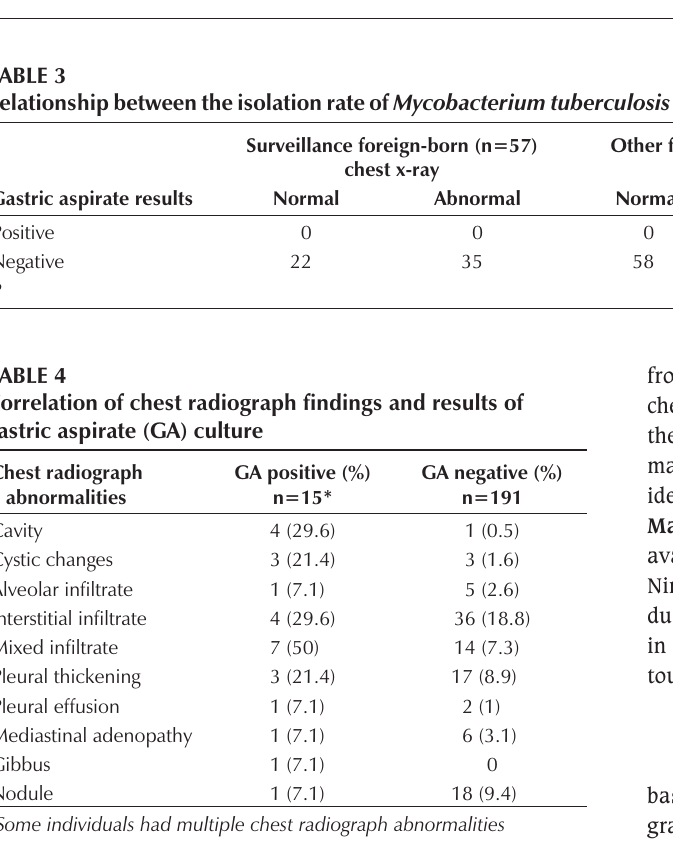
Relationship between gastric aspirate positivity for Mycobacterium tuberculosis and symptoms in each group Surveillance foreign-born (n=57) Other foreign-born (n=110)